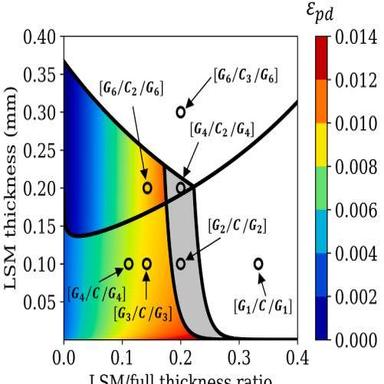
Colour contour damage mode map of pseudo-ductile strain for 3D printed continuous carbon fibre-fibreglass hybrid composites. The circles represent the laminate configurations that were evaluated in the present study. The right side colour bar represents the pseudo-ductile strain. Note: The grey shaded region represents laminate configurations that may exhibit premature failure. (For interpretation of the references to colour in this figure legend, the reader is referred to the web version of this article.)